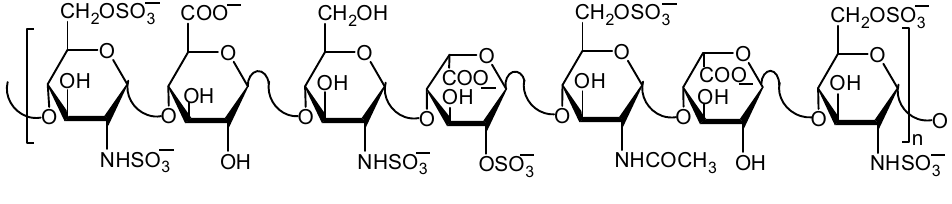
Figure 12. A representative chemical structure of UFH and LMWHs. These sulfated glycosaminoglycans exhibit remarkable antithrombin-mediated anticoagulant activity and anti-inflammatory and antiviral effects. Heparan sulfate proteoglycans, proteins that are heavily decorated with sulfated